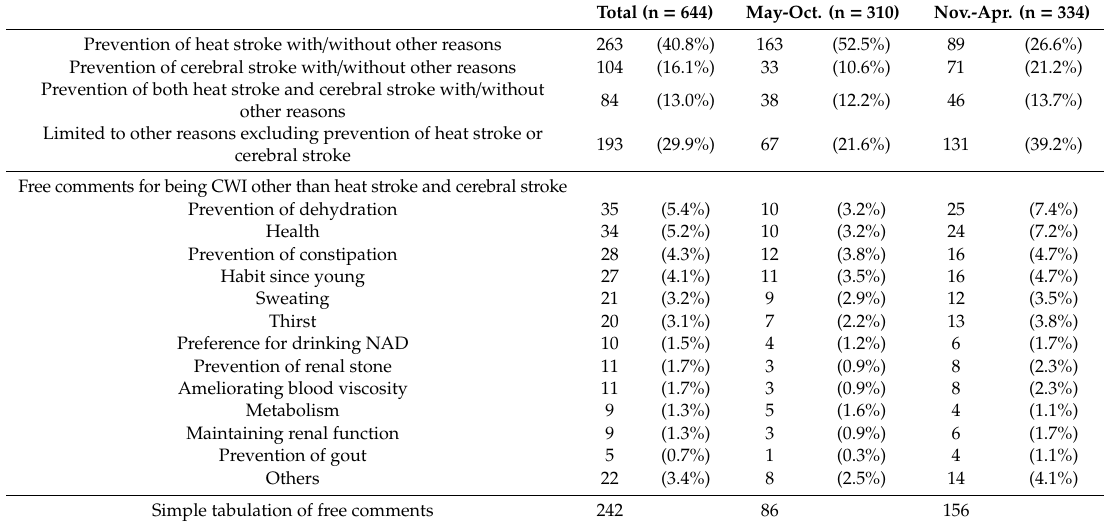
Table 2. The reasons for being conscious of water intake, according to seasons.